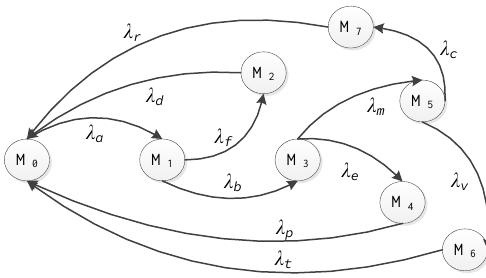
Figure 12. Defense Scenario III: the isomorphic model with the MC and the making process of